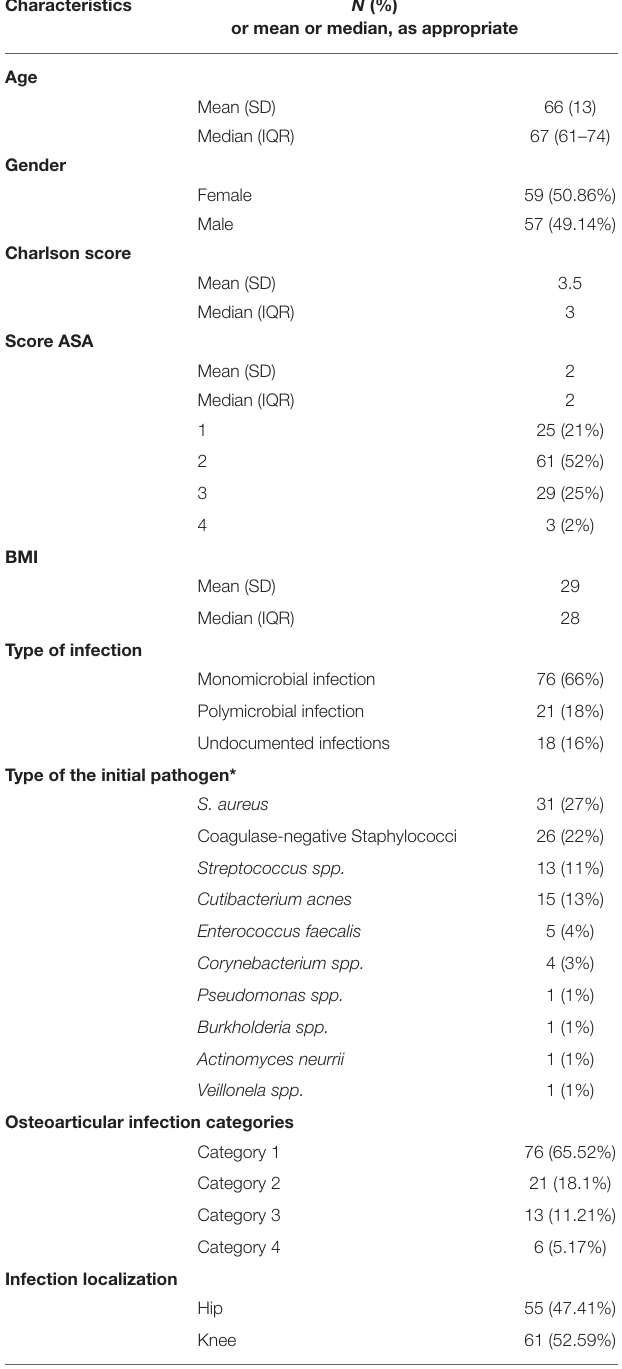
TABLE 1 | Main characteristics of the study population ( n = 116).